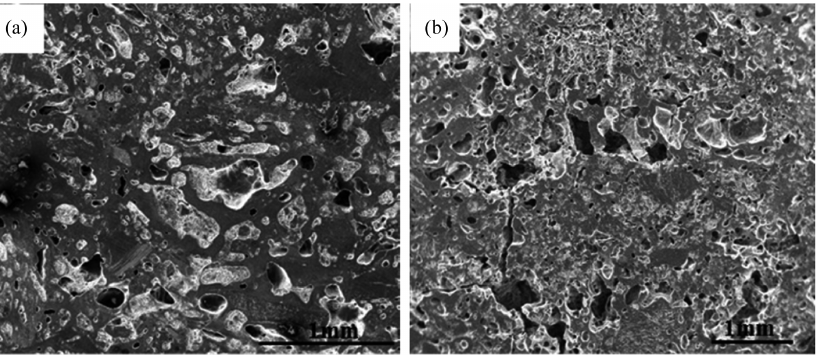
Figure 7: SEM images of coke sample before the gasification reaction: (a) normal coke; (b) ferro-coke.